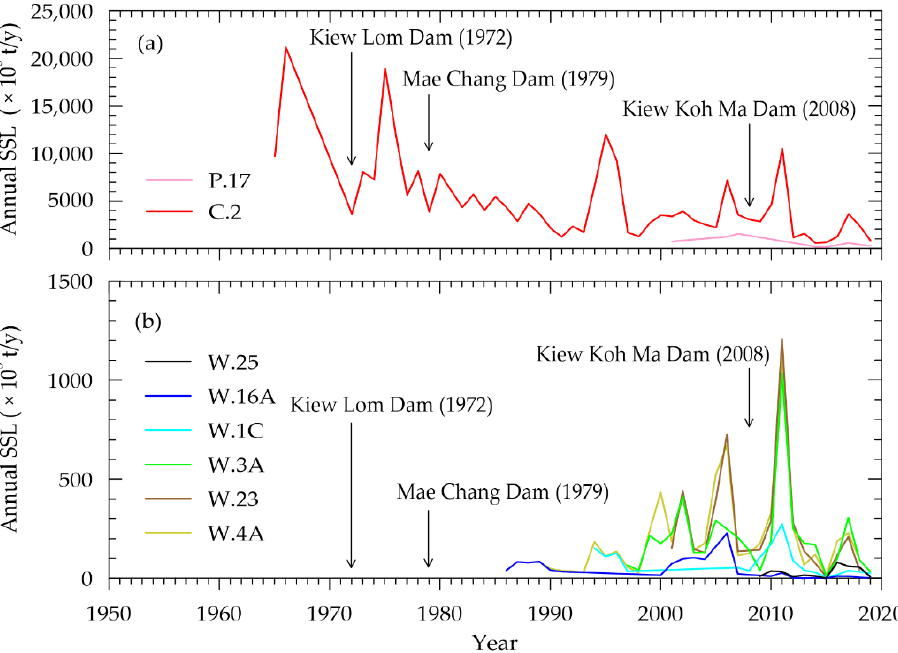
Figure 5. Time series data of annual total sediment load at the RID hydrological stations between 1965 and 2019: ( a ) P.17 and C.2; ( b ) W.25, W.16A, W.1C, W.3A, W.23, and W.4A.